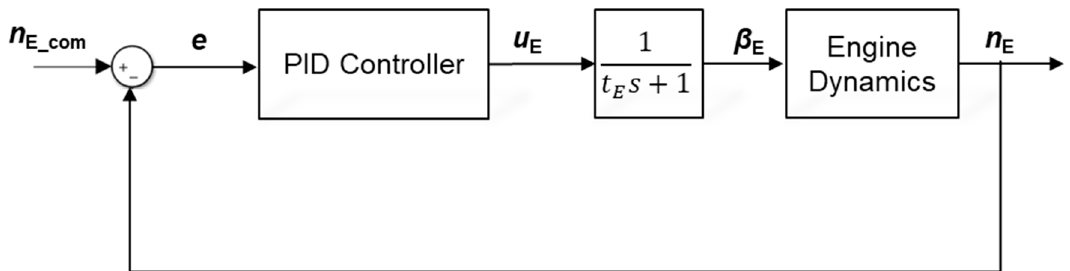
Figure 5. Engine Speed Controller.